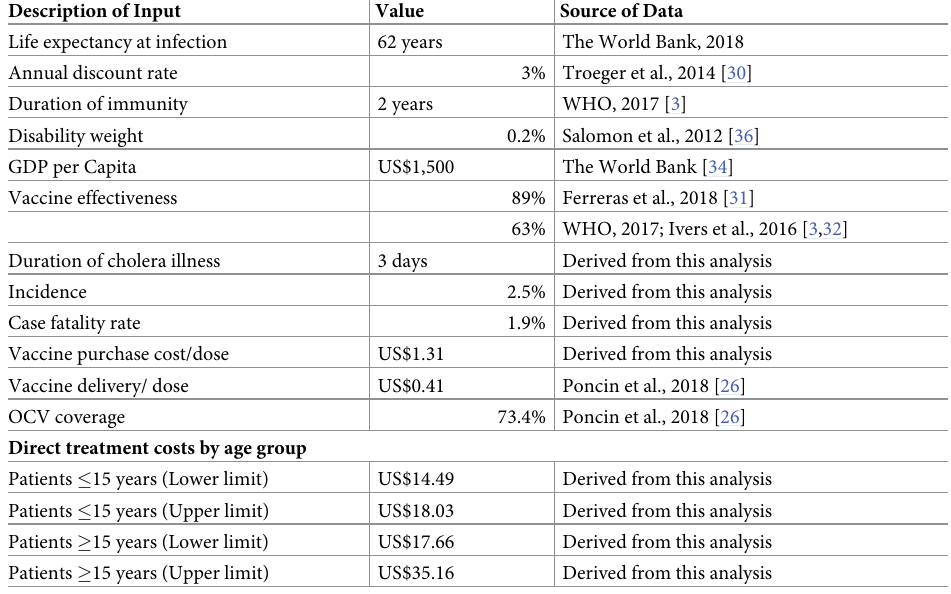
Table 2. Parameter values assumed for computing cost-effectiveness of a vaccination campaign using a single dose of Shancol in